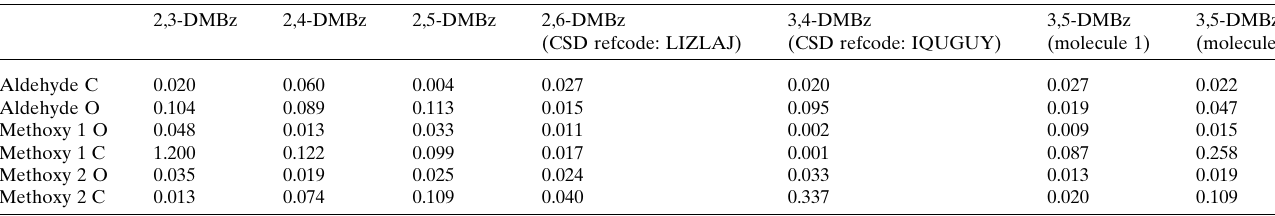
Table 1 Deviation from the aromatic plane (in A˚ ).